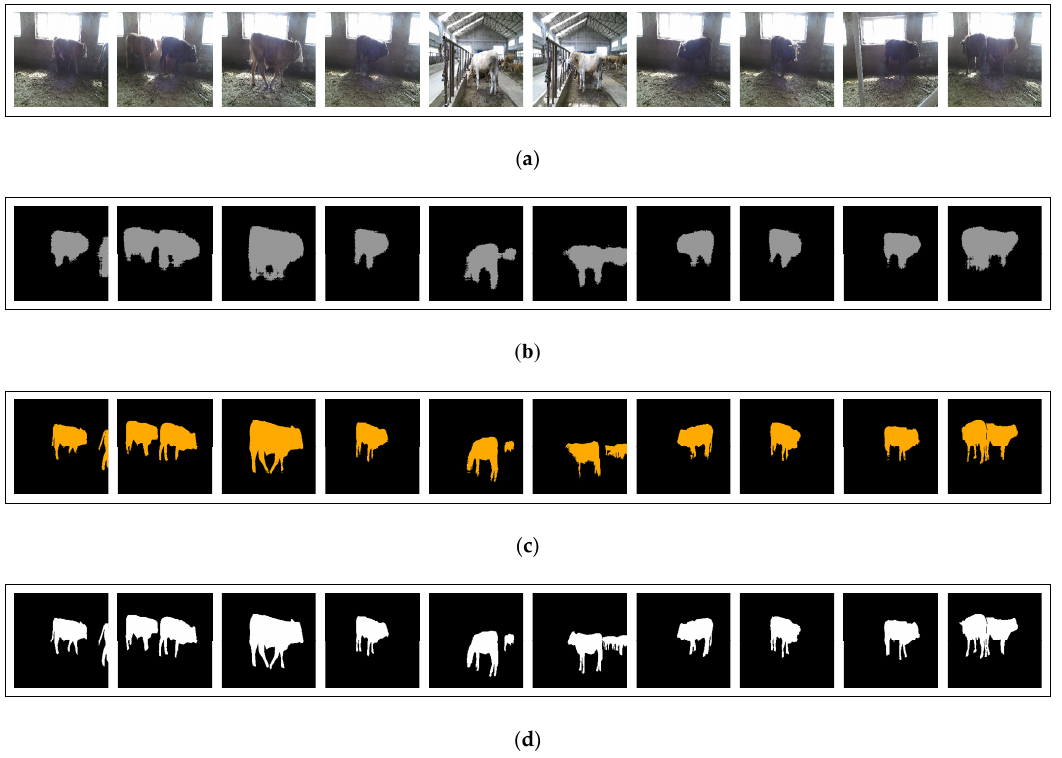
Figure 9. The comparison of semantic segmentation results. ( a ) Original RGB images. ( b ) The semantic segmentation results of fully convolutional networks. ( c ) The semantic segmentation results of depth density. ( d ) Ground truth of semantic segmentation.